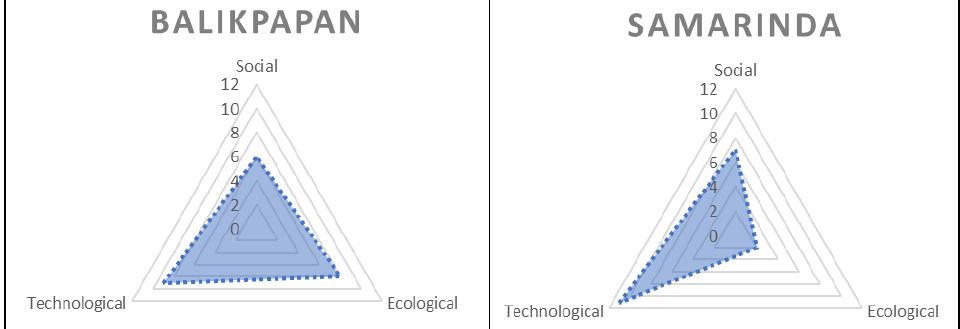
Figure 2. Distribution of the SETS dimensions in Balikpapan and Samarinda (Source: authors).